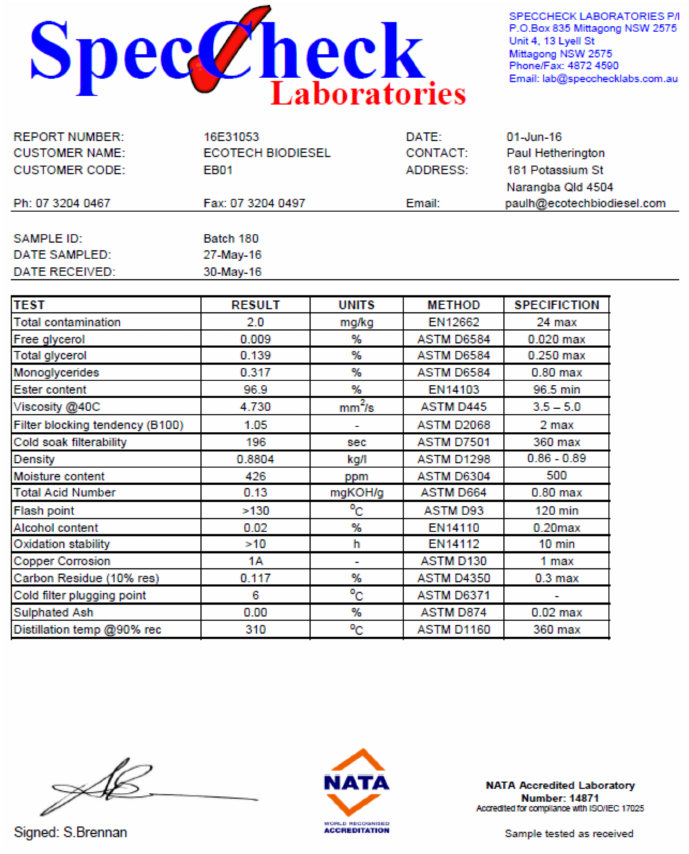
Figure A2. Quality certificate of